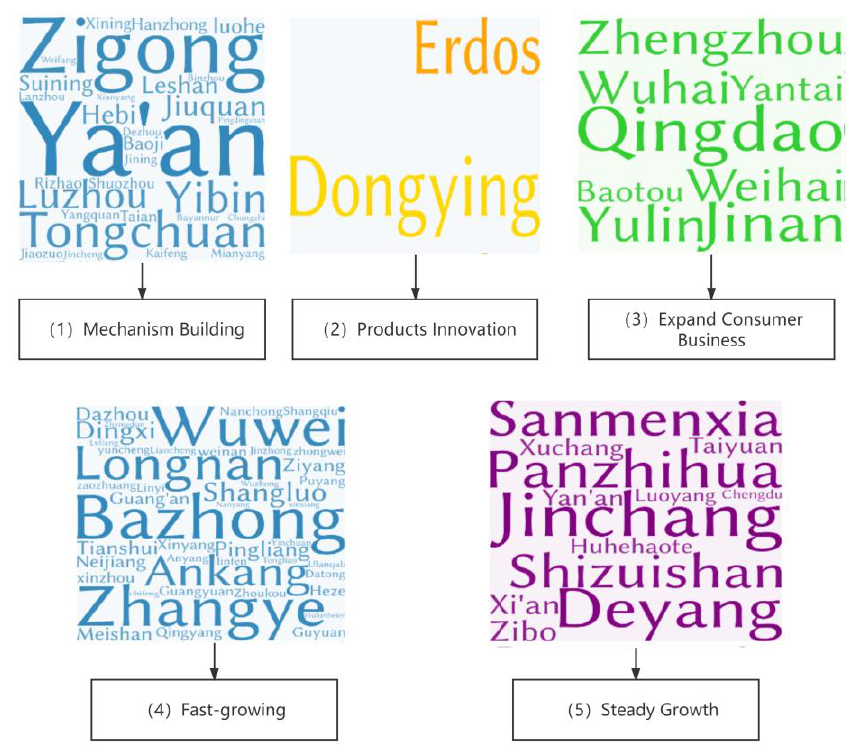
Figure 7. Green credit development patterns for cities in the Yellow River Basin.